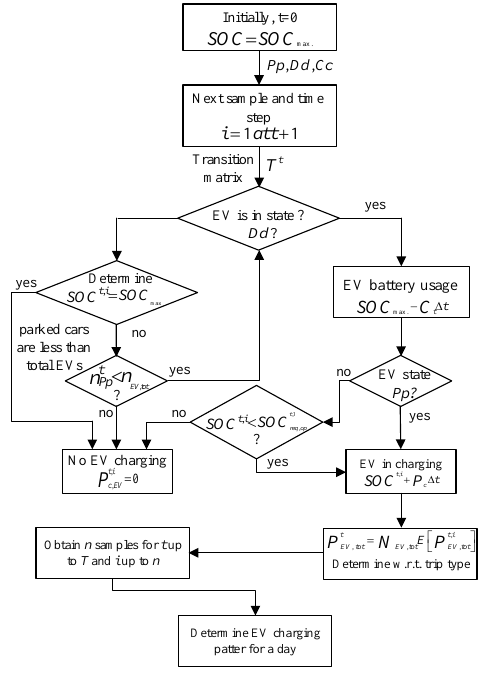
Figure 4. Simulation